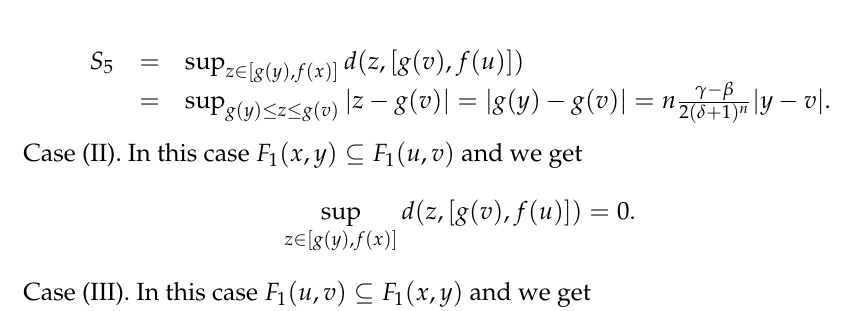
Figure 1. Case (I) x ≤ u and y ≤ v